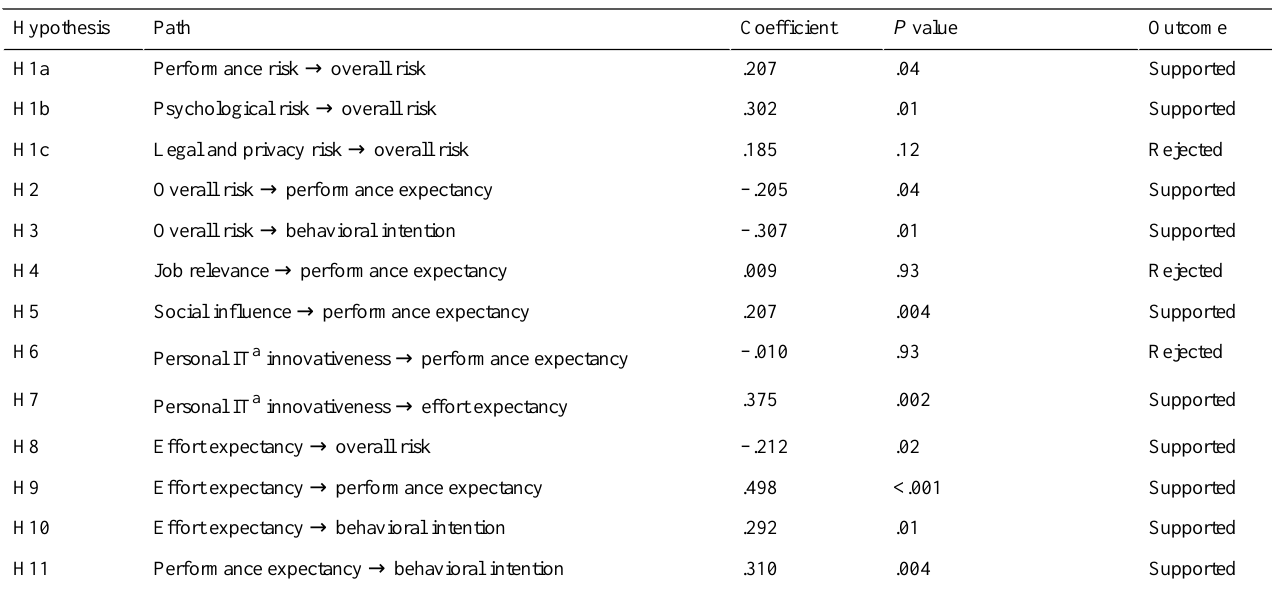
Table 2. Hypothesis test results for the EHR user